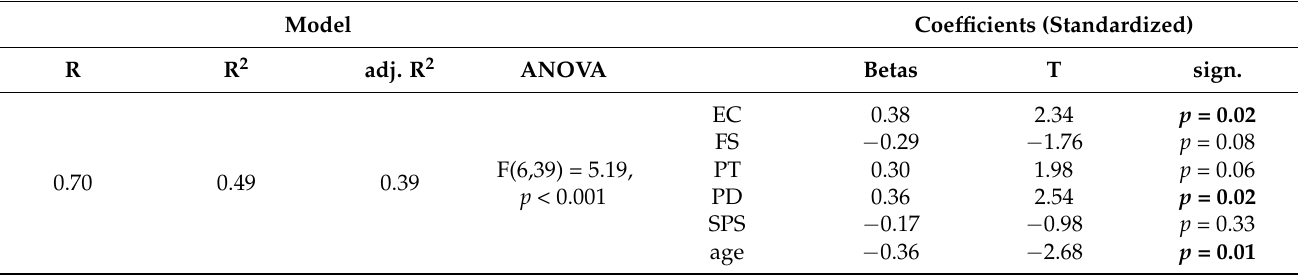
Table 3. Regression analyses of tactile performance of the right hand with personality measures and age as predictors (significant results in